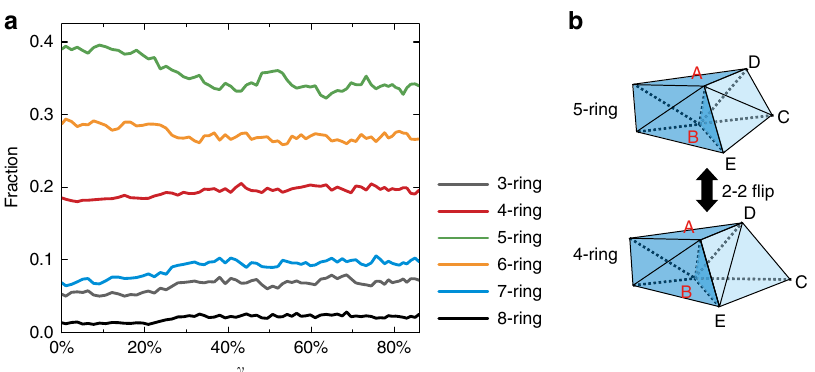
Fig. 4 Evolution and transformation of N-ring structures under shear. a Evolution of the fraction of N-ring structures upon shear. b A 5-ring structure with AB as common axis, evolves into a 4-ring structure as the couple ABCE/ABCD forms a new couple DEBA/DEBC through 2 – 2 fl ip as AC and DE switch